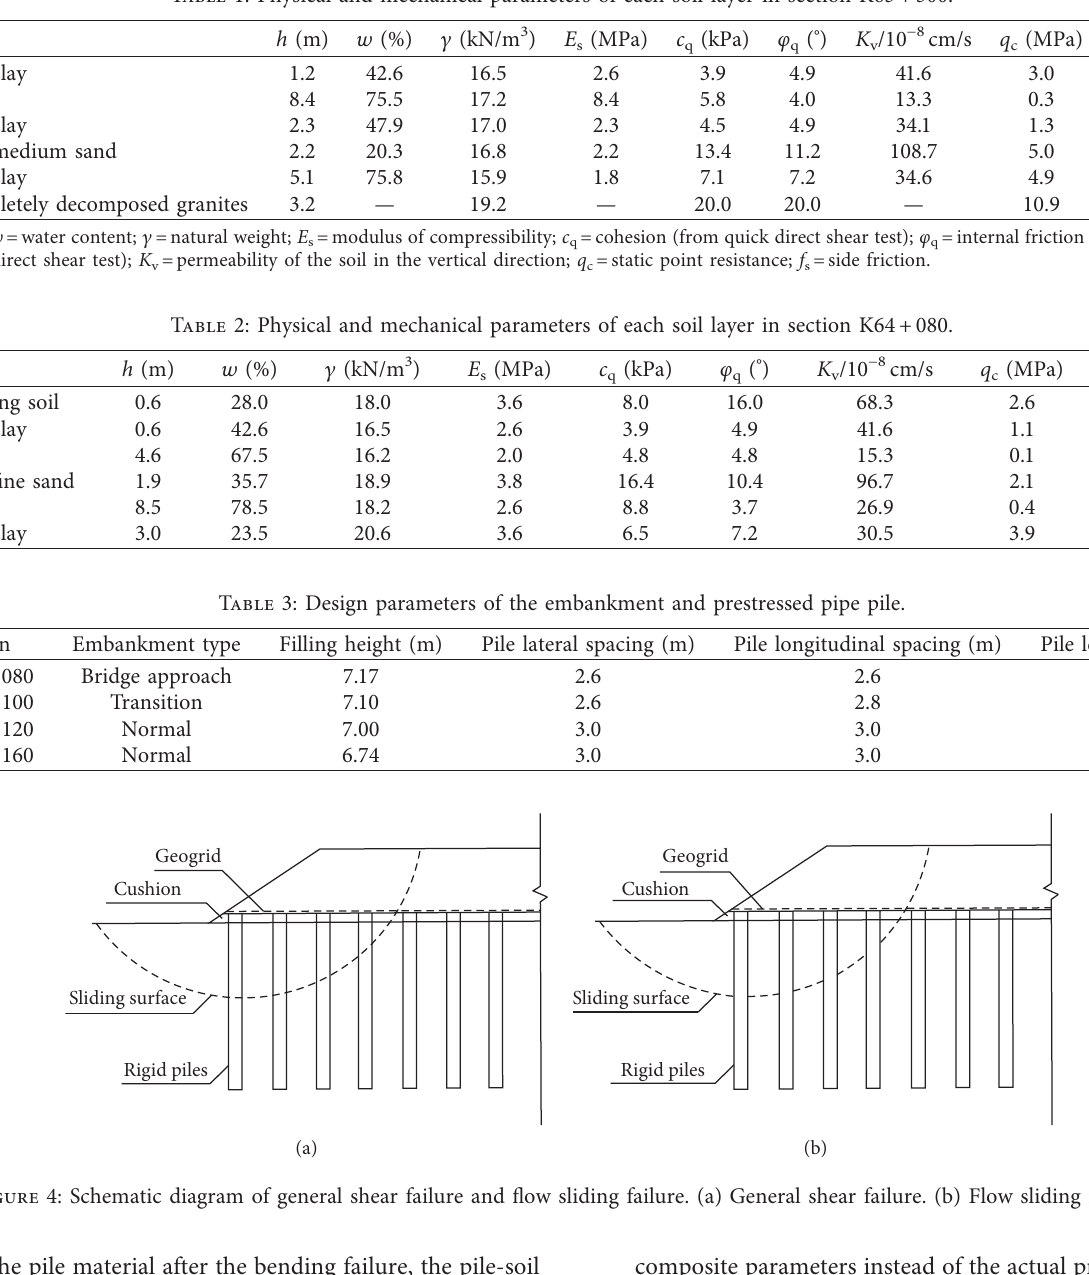
Table 1: Physical and mechanical parameters of each soil layer in section K63 +500.